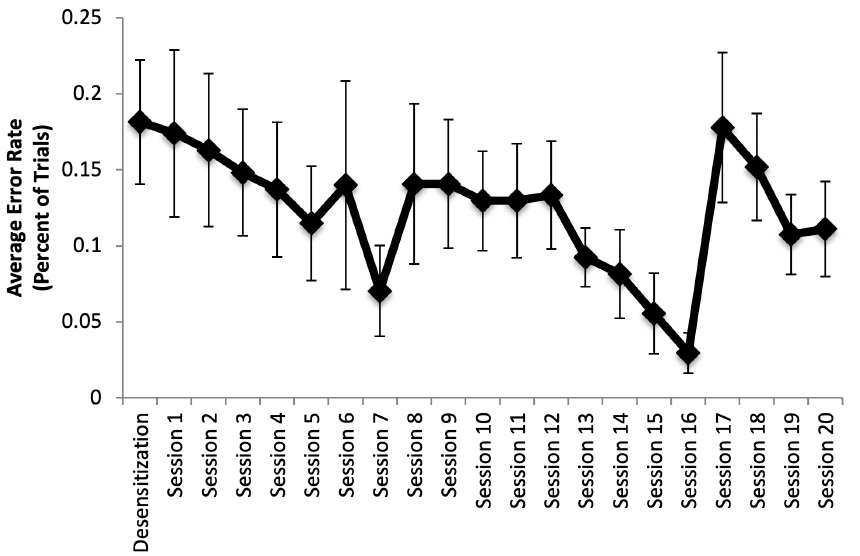
Figure 7. Response error rate by session in Phase 2: Stage 6, averaged across capuchins. Error rate was calculated by determining the number of errors divided by 27 trials per session. No significant differences were found across